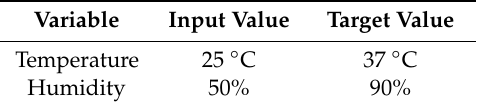
Table 3. Initial inputs and target values used in tests.